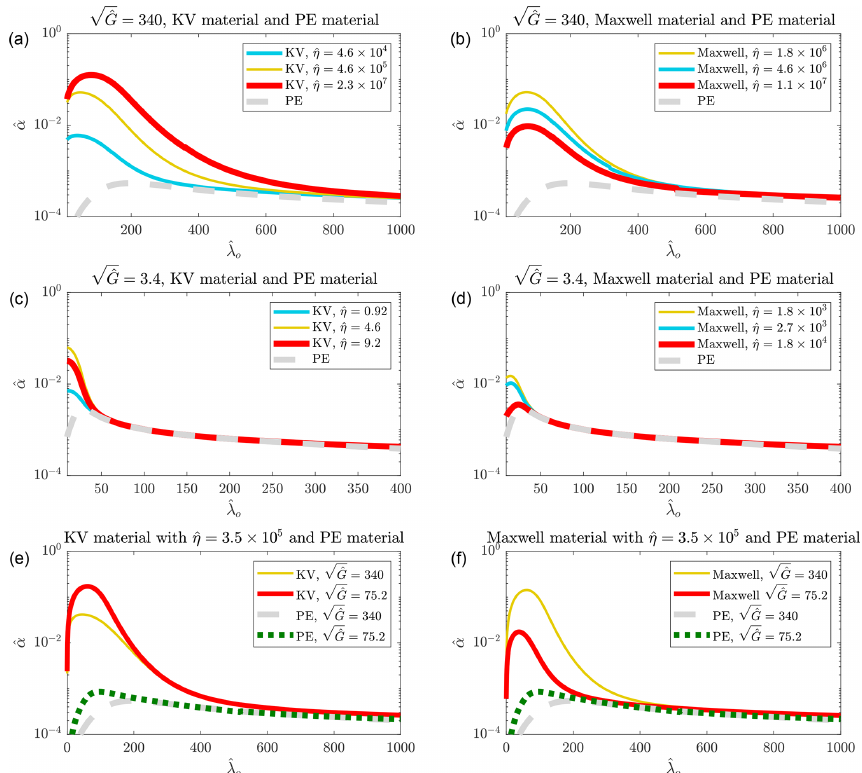
Figure 2. Effects of the dynamic viscosity (a–d) and elasticity number (e, f) on ˆ α vs. the ˆ λ o curves different solid models give. Dashed and dotted models denote the decay rates that a PE material (RP model with consideration of added mass force) predicates.